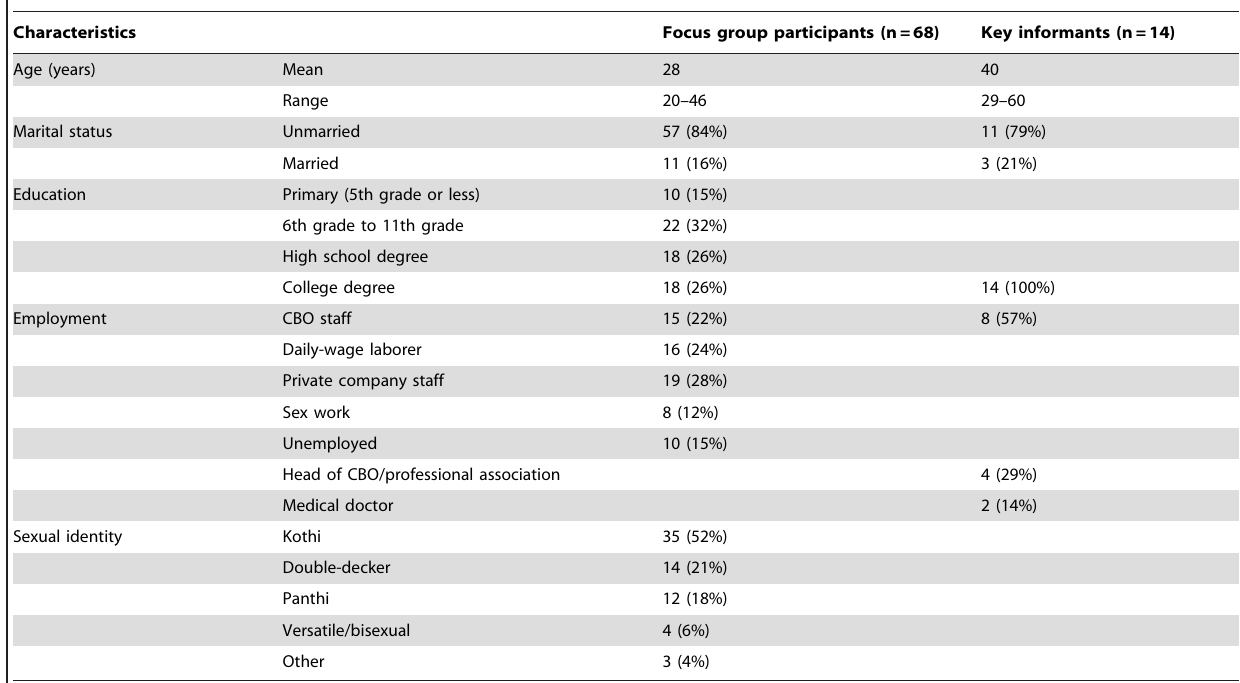
Table 1. Sociodemographic characteristics of study participants (n=82).